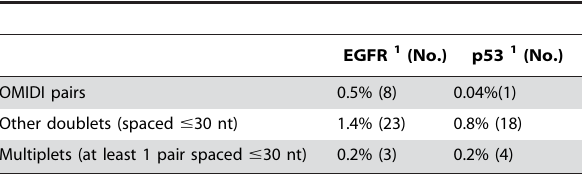
Table 5. Closely spaced doublets and multiplets detected in the EGFR and TP53